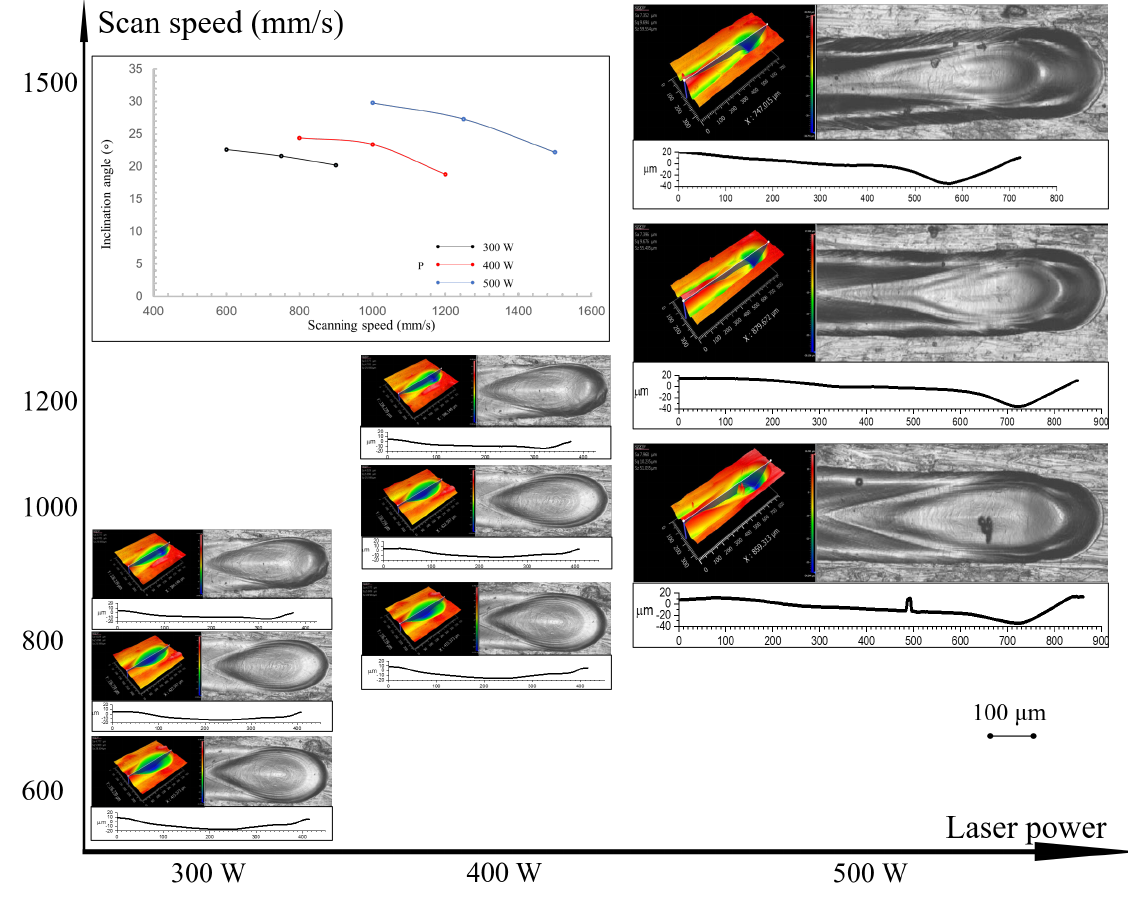
Figure 4. Depth map and geometry of depression zone at the end of each track. Scale: 100 µ m for the measured curves at the bottom of each